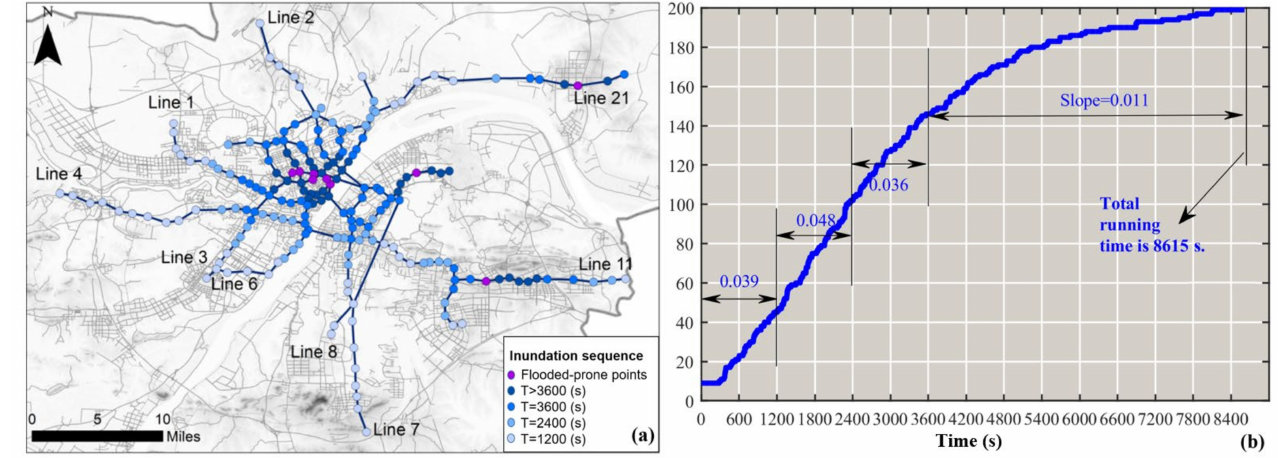
Figure 13. ( a ) Inundation sequence and ( b ) proportion of breakdown nodes over